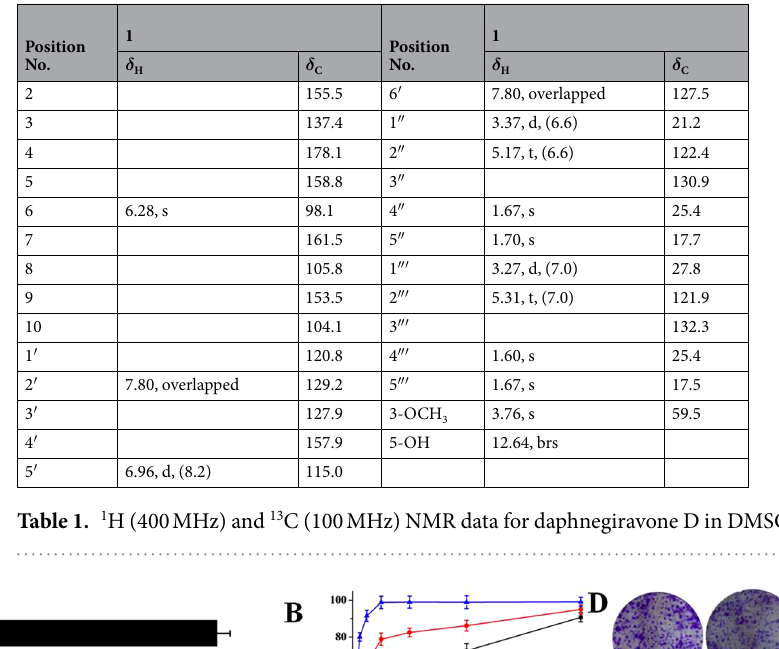
morusin ( 3 ) displayed extensive and moderate cytotoxic activities against most cancer cell lines, with IC 50 values of about 20 μ M, and daphnegiravone A ( 4 ) and daphnegiravone C ( 5 ) exhibited almost no cytotoxicity for their IC 50 values were greater than 50 μ M against most cell lines. Additionally, data also indicated that daphnegiravone D ( 1 ) exhibited potent cytotoxicity in a concentration and time-dependent manner against human hepatoma Hep3B and HepG2 cells (Fig. 2B and C) with IC 50 values of 1.63 and 9.89 μ M, respectively. Also, its relatively weak cytotoxicity on other cancer cell lines and no obvious effect on normal human hepatic cells (LO2 cells with an IC 50 value of 45.08 μ M) suggested that daphnegiravone D selectively inhibited hepatoma cells (Fig. 2A). In order to confirm the effect of daphnegiravone D on hepatic cancer cells, clonogenic assay was performed. As shown in Fig. 2D and E, the colonies of Hep3B and HepG2 cells were dramatically reduced by daphnegiravone D in a dose-dependent manner. In summary, daphnegiravone D had a strong anti-proliferative effect on hepatoma cells. Daphnegiravone D results in G0/G1 arrest through downregulating cyclin E1, CDK2 and CDK4 in Hep3B and HepG2 cells. The cell cycle is a successive, tight and integrated physiological process that administrates proliferation, growth, and survival of cells. Abnormal cell cycle distribution can lead to decrease